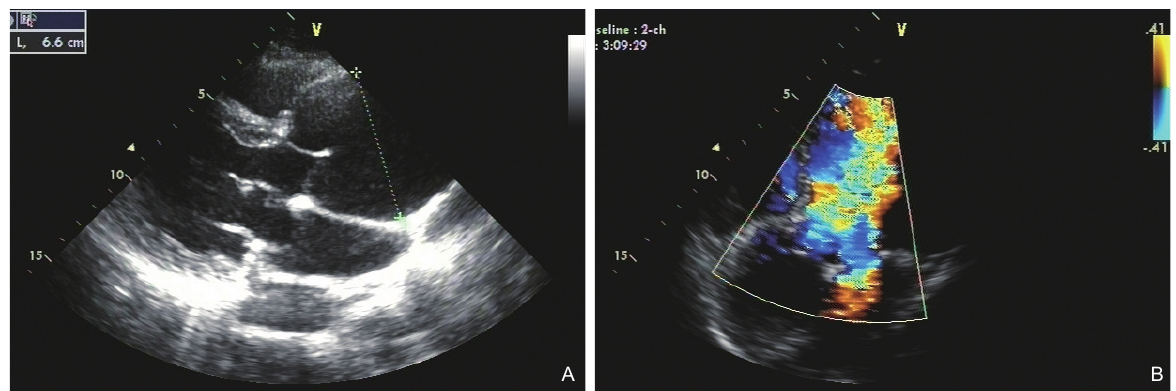
A Figure 2 Ultrasound images of the patient from February 2015 (A)Parasternal Long-Axis View showed that the aortic sinus was dilated up to 66 mm. (B) There was a lot of regurgitation in the aortic valve.